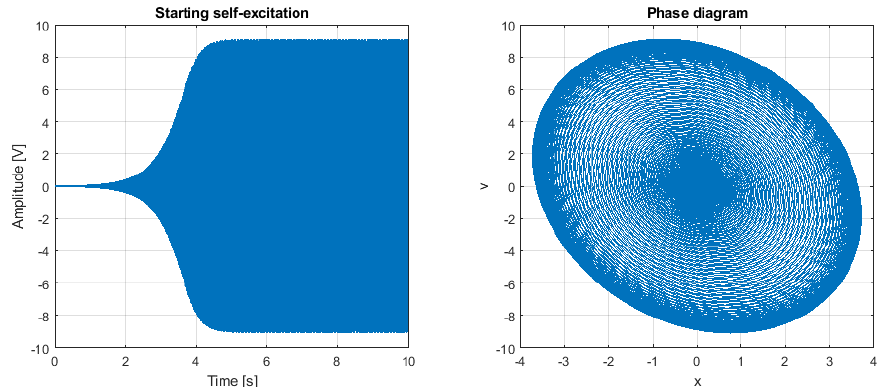
Figure 4. Example of excitation progress of the SAS system and its limit